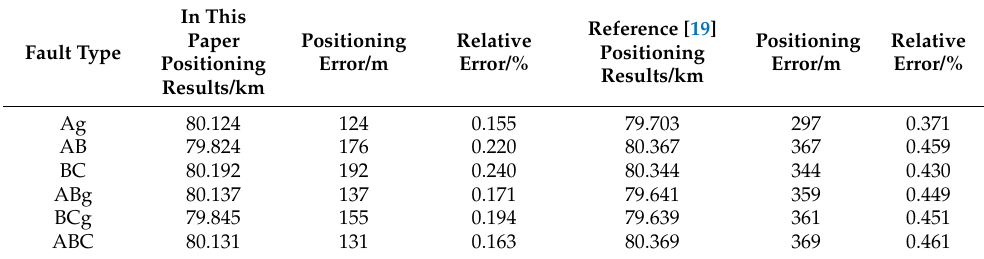
Table 2. Location error under different fault types.